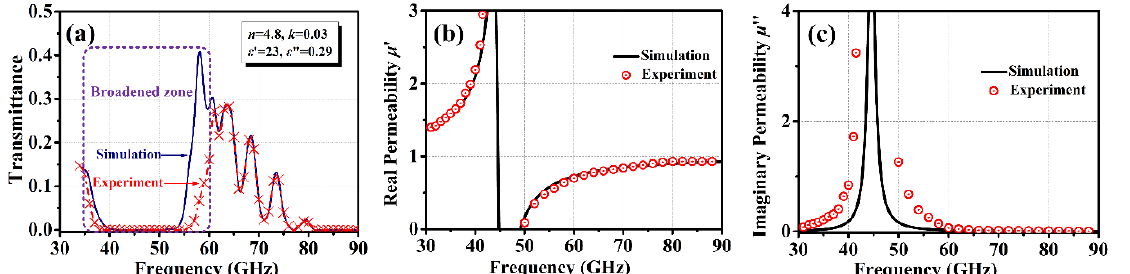
Figure 4. Millimeter-wave transmittance spectra, and real and imaginary parts of magnetic perme- ability in crystallographically textured Ba 0.8 La 0.2 Fe 11.8 Cu 0.2 O 19 sample as a function of frequency: ( a ) Millimeter-wave transmittance spectra; ( b ) real parts of magnetic permeability; ( c ) imaginary parts of magnetic permeability.